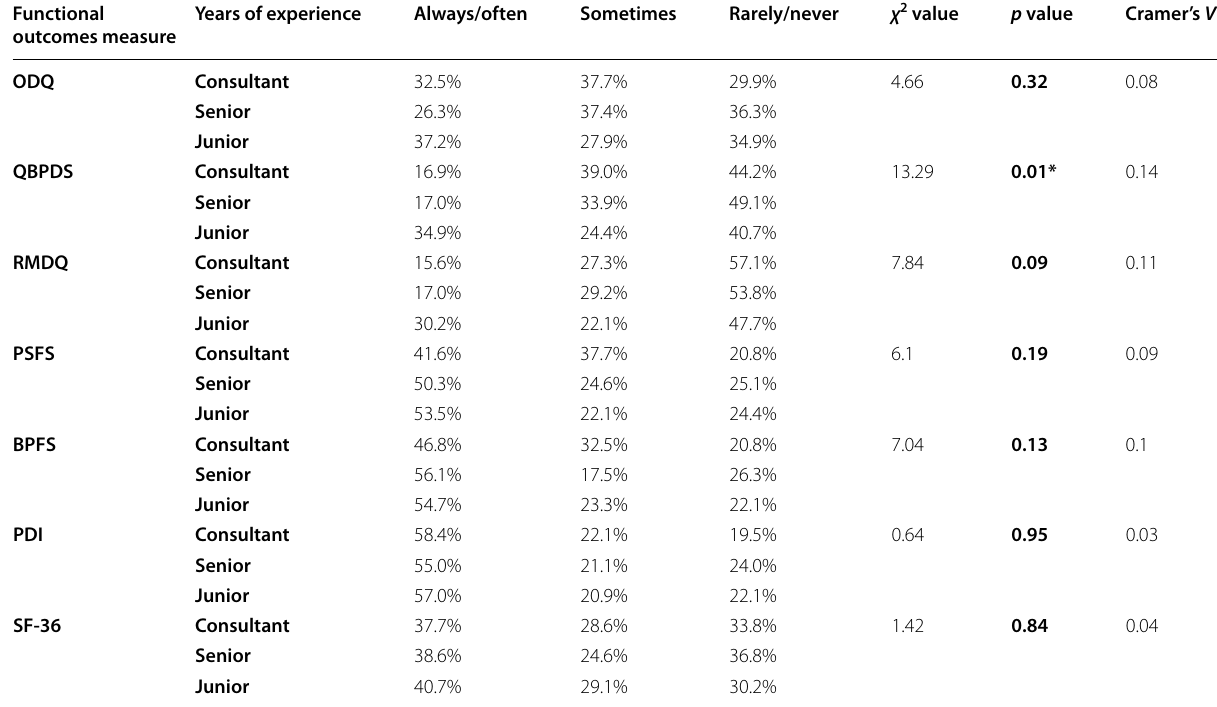
χ 2 chi-squared value; p value , probability value; *significant